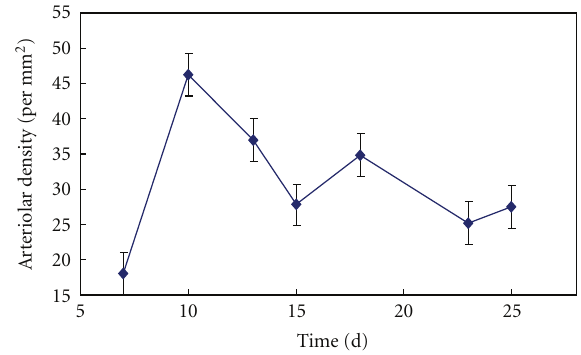
Figure 4: The curve of arteriolar density change with time in conjunct area between material and tissue.